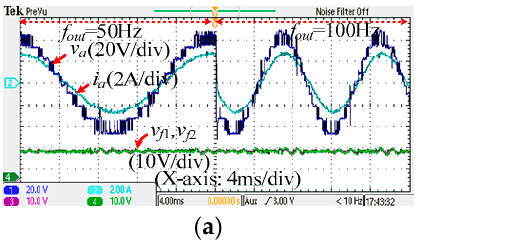
Figure 31. Steady ‐ state experiment results of single ‐ phase 9L HSM converter connected with linear RL ‐ load. ( a ) Switching signals, ( b ) Output voltage v ao between X 1 and o, ( c ) phase voltage v a and load current i a , ( d ) deviations of FC voltages and load current.